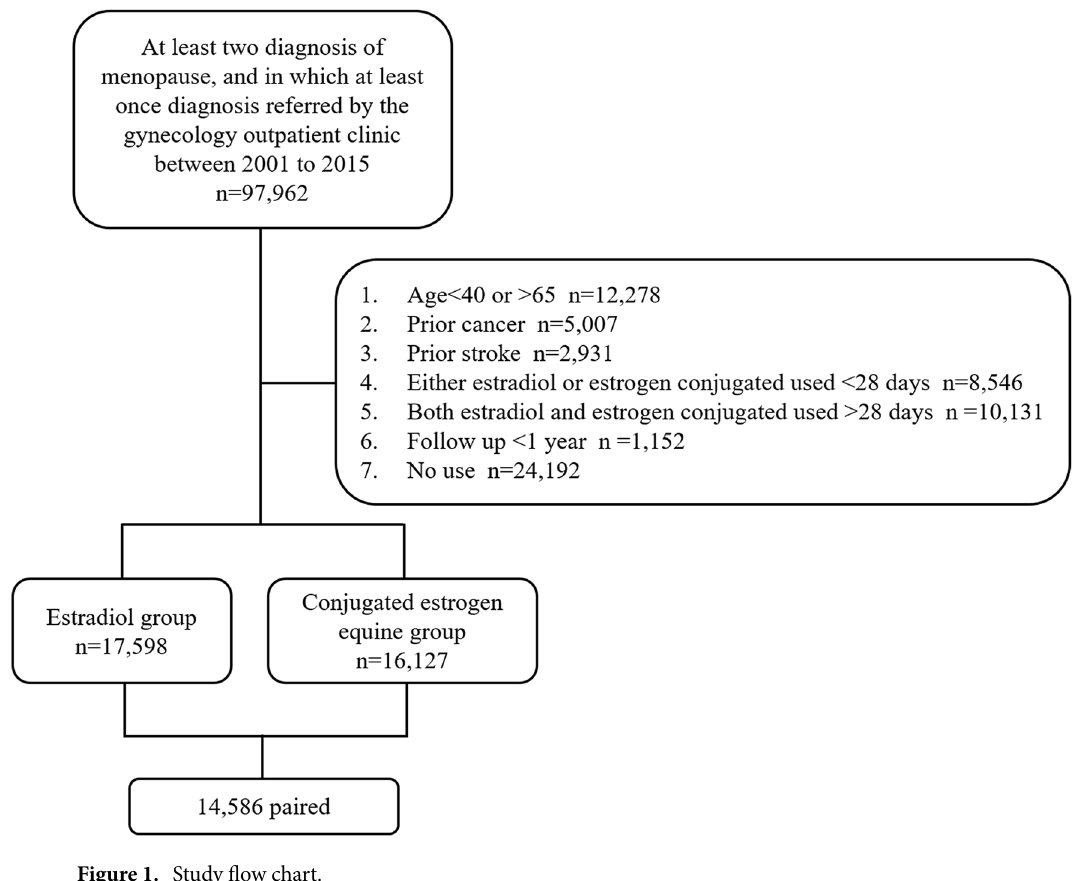
Figure 1. Study flow chart.